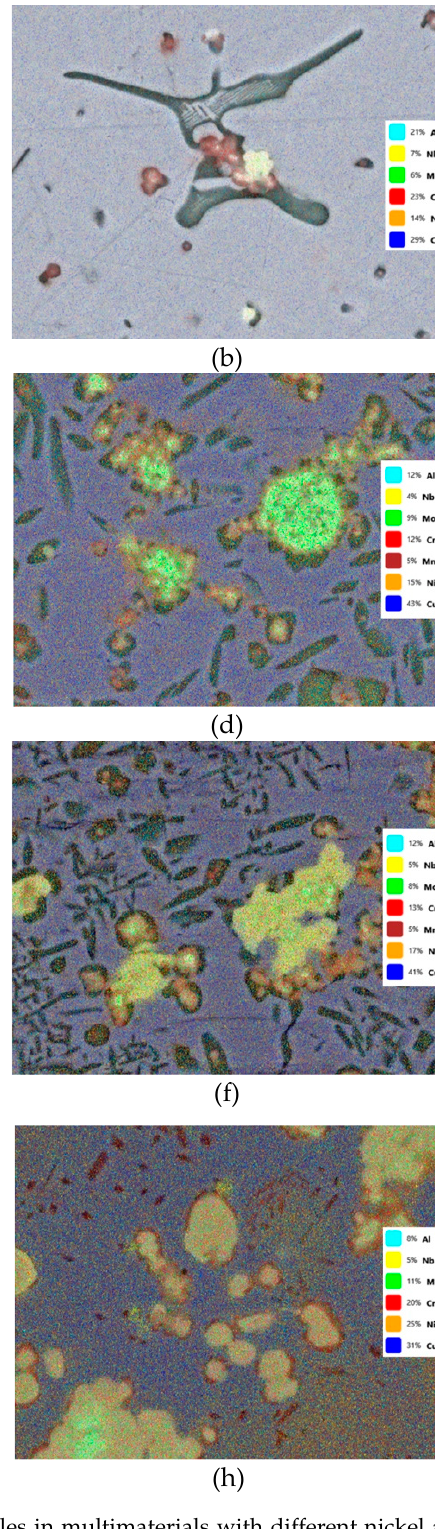
Figure 4. SEM images of the main formed particles in multimaterials with different nickel alloy content: ( a , b )—5%Ni, ( c,d )—15%Ni, ( e,f )—25%Ni, and ( g,h )—50%Ni.